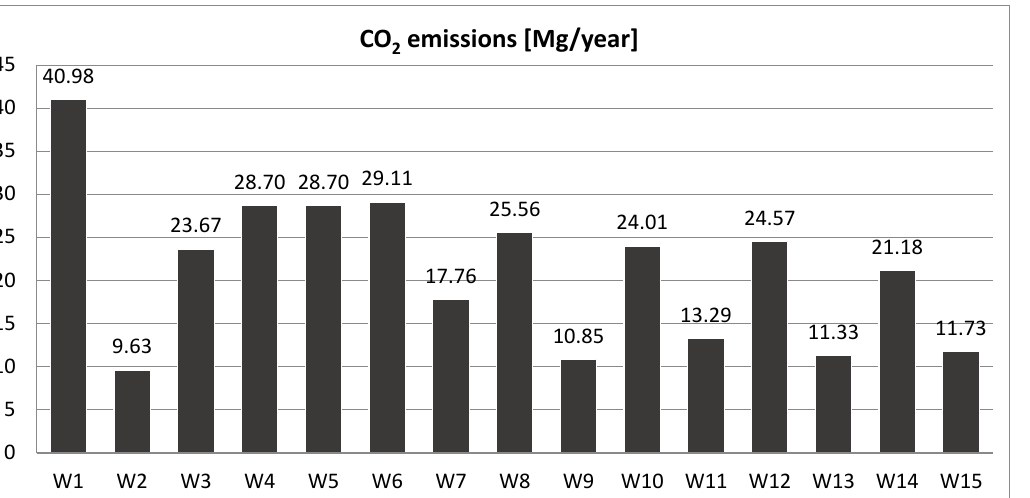
Scheme 9. Comparison of primary energy demand ratios indicators PE for various heat sources and energy